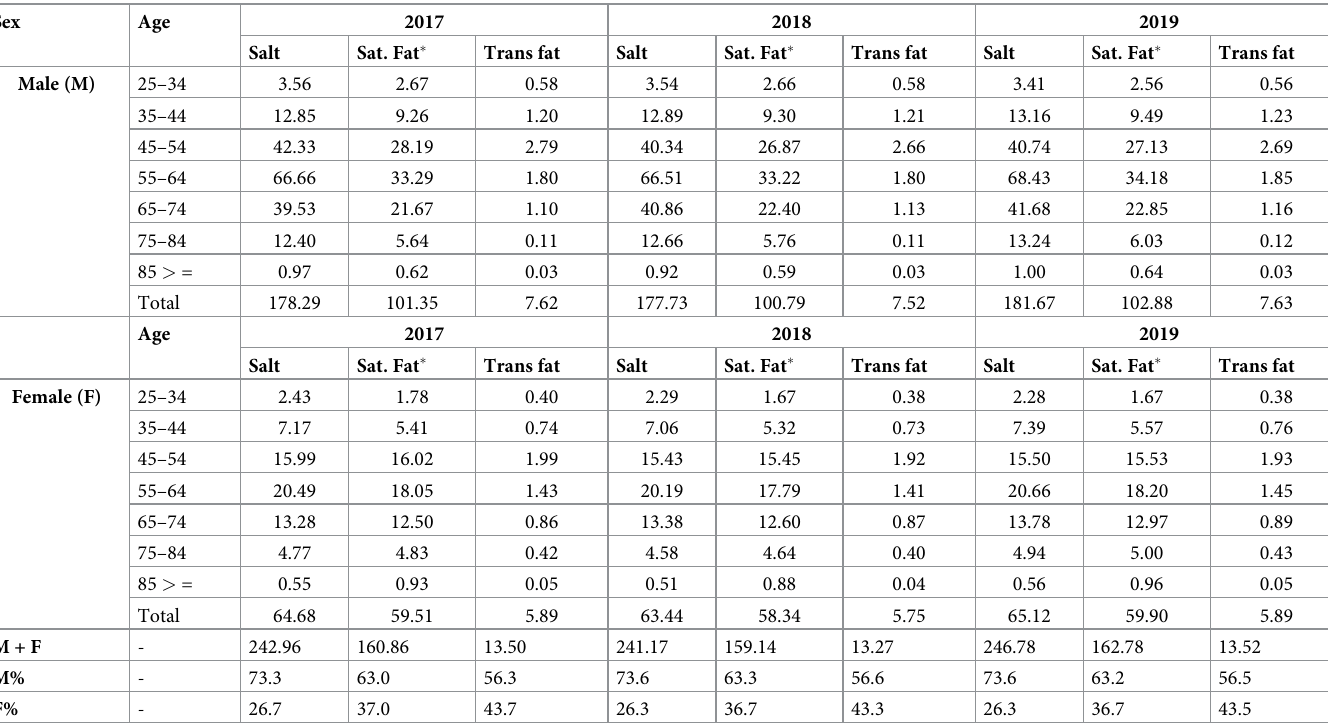
Table 2. Direct costs attributable to excess consumption of nutrients (salt, saturated fat and trans-fat) by sex and age group in US$ per Million. Sex